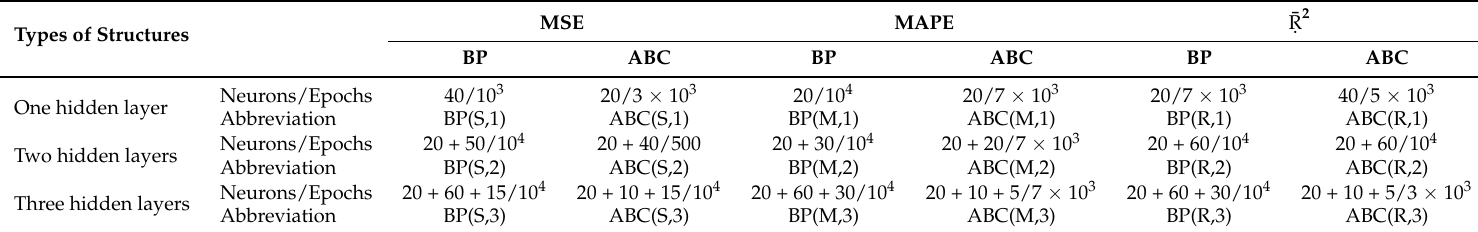
Table 4. ANNs with the lowest MAPEs (mean absolute percentage error) and